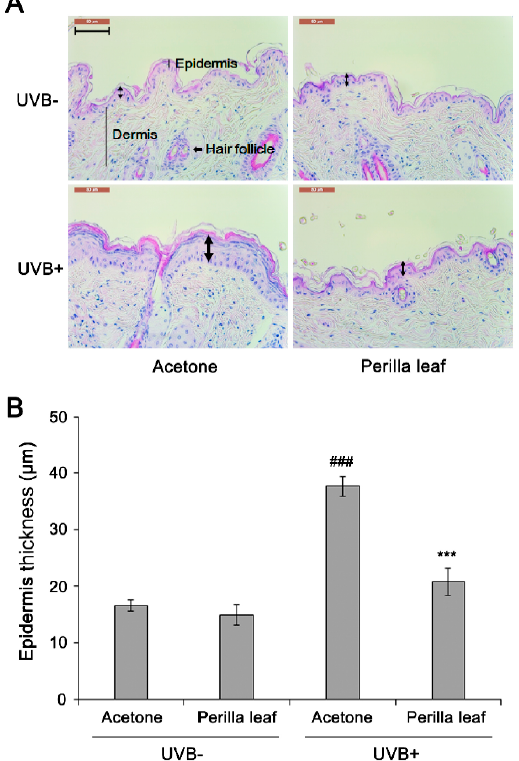
Figure 1. Perilla leaf extract suppressed UVB-induced epidermal thickening in FVB mice. ( A ) H&E- stained section of mouse dorsal skin after Ultraviolet B (UVB) exposure. Perilla leaf extract (5% w/v in acetone) was applied to mouse skin, which was then irradiated with UVB for 30 min. UVB-in- duced epithelial cell proliferation was evaluated in each indicated group (ten mice per group), after 2 weeks of UVB irradiation was completed. The photograph shows skin from a representa- tive mouse. Bold arrows indicate epidermis. The scale bar represents 100 μ m. ( B ) Quantification of epidermis thickness in UVB-induced epithelial layers. Data are expressed as means ± SDs. ### p < 0.001 as compared with non-radiated mice by the t-test. *** p < 0.001 as compared with the UVB- irradiated control group by the t -test. 3.2. Induction of Perilla Callus Formation Using Different Media Next, we established a means of culturing Perilla calluses, a well-known nutraceutical [12]. Calluses were induced from Perilla leaves over four weeks using three media types: M&S medium, M&S modified medium, and 2,4-D medium. Interestingly, Perilla callus induction was observed after five days of culture on 2,4-D medium and proliferated after nine days (Figure 2A,B). In contrast, induction of Perilla calluses was observed after nine days of culture on M&S modified medium, but Perilla calluses barely proliferated. Callus formation was more rapid in 2,4-D medium than in the other two media ( p < 0.001, Figure 2A). Perilla calluses produced on 2,4-D medium, M&S modified medium, or M&S medium in five weeks were weighed (Figure 2C), and the amount of callus produced was larger on 2,4-D medium than on M&S modified medium (20.38 mg versus 5.78 mg, respectively). Callus formation was not induced in M&S medium. These observations showed 2,4-D medium containing 2,4-dichlorophenoxy acetic acid (2,4-D) provided an effective me- dium for Perilla callus induction and suggested that 2,4-D may be crucial for Perilla callus induction.